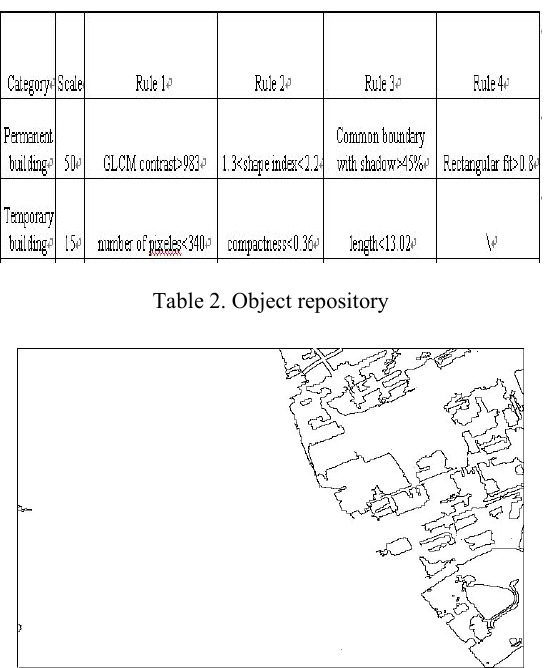
Figure16. Permanent architecture extraction